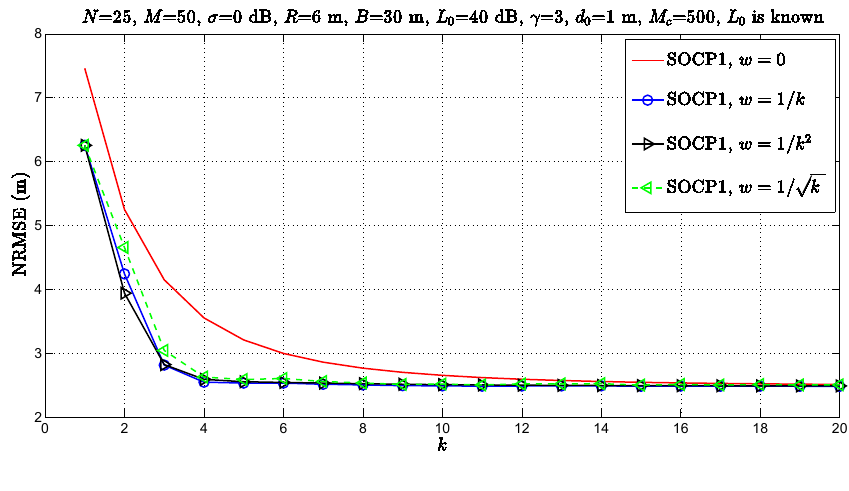
Figure 7. NRMSE versus number of iterations comparison of the proposed approach for different choices of w .